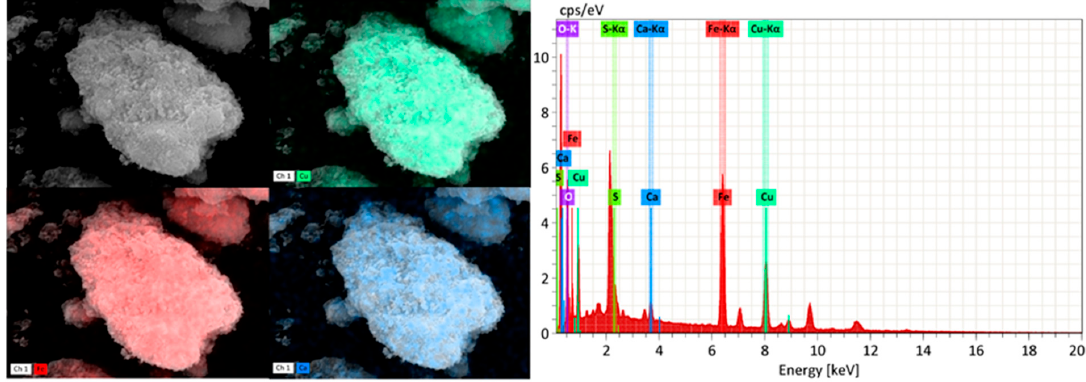
Figure 3. Morphology and SEM-EDS of the copper sludge sample.